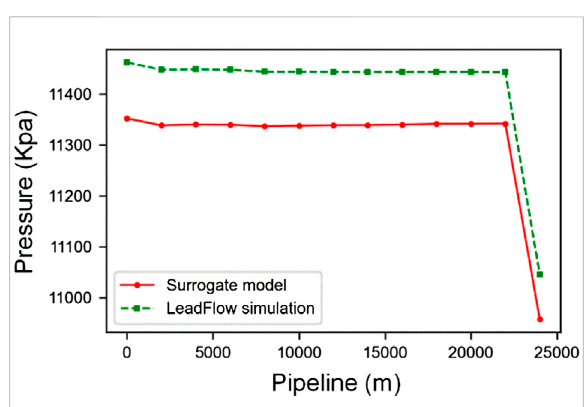
FIGURE 7 Thechangeofpressurealongthepipelinebetweensurrogate mode and LeadFlow